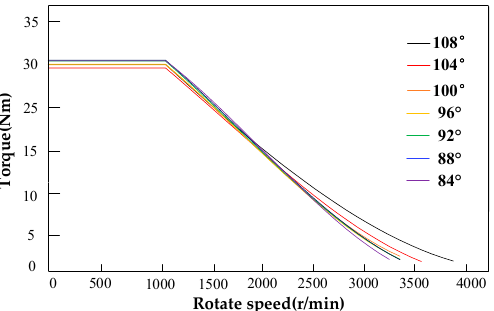
Figure 15. The torque–speed curve with different angle between the V-type permanent magnets.